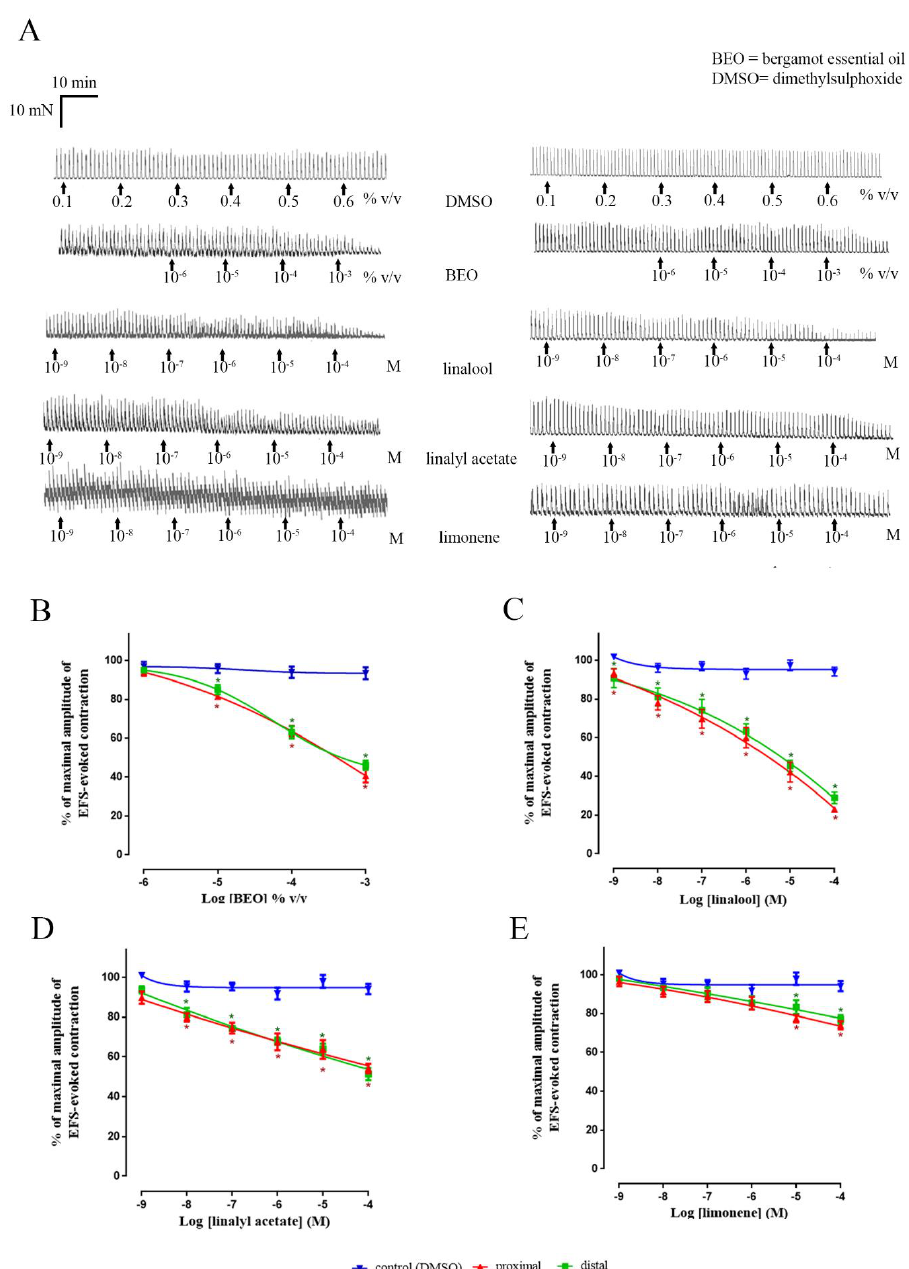
Figure 3. E ff ect of BEO and its main components on EFS-evoked contractions in rat isolated colon. The examples of experimental records illustrating the pharmacology of responses are shown in panel ( A ) (records on left and right show the e ff ect observed in proximal and distal colon, respectively). Panels ( B–E ) show the concentration–response curves determined by BEO, linalool, linalyl acetate, and limonene in both regions of colon. Note that the values for BEO, an oil, are given as volume/ volume of bathing solution, whereas the concentrations of the individual compounds are given as molar values. Each point represents the mean of animals studied: DMSO n = 3, BEO n = 4 ( n = 4 proximal and n = 4 distal), linalool n = 4 ( n = 4 proximal and n = 4 distal), linalyl acetate n = 4 ( n = 4 proximal and n = 4 distal), limonene n = 4 ( n = 4 proximal and n = 4 distal). The cumulative concentration-e ff ect were fitted by non-linear regression to a four-parameter Hill equation. Vertical lines show standard error of mean. EFS (5 Hz, pulse width 0.5 ms, for 10 s every 1 min). EFS = electrical field stimulation. * p ≤ 0.05 shows the statistical significance between proximal (symbols in red, *) or distal (symbols in green, *) colon versus control ( t- tests). There was no di ff erence ( p > 0.05) between the data obtained using the proximal and distal